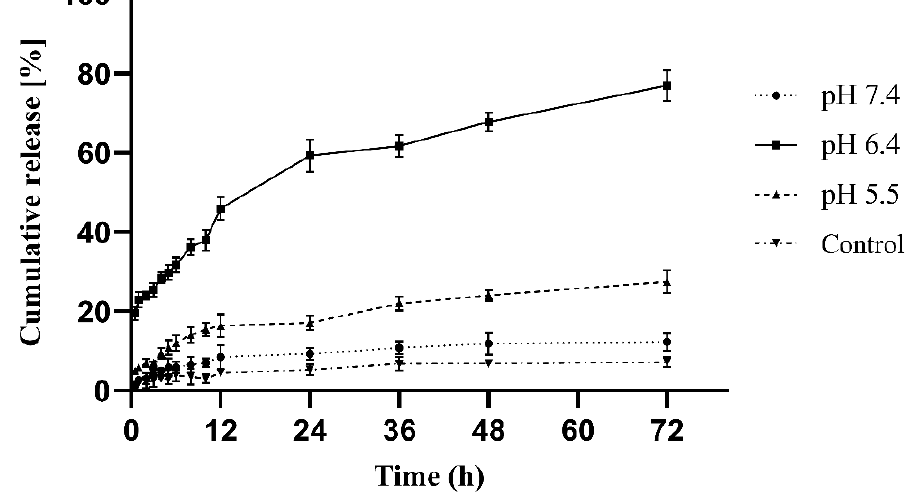
Figure 11. In vitro release profile of pH-sensitive nanoformulation at pH 7.4, 6.4, 5.5.